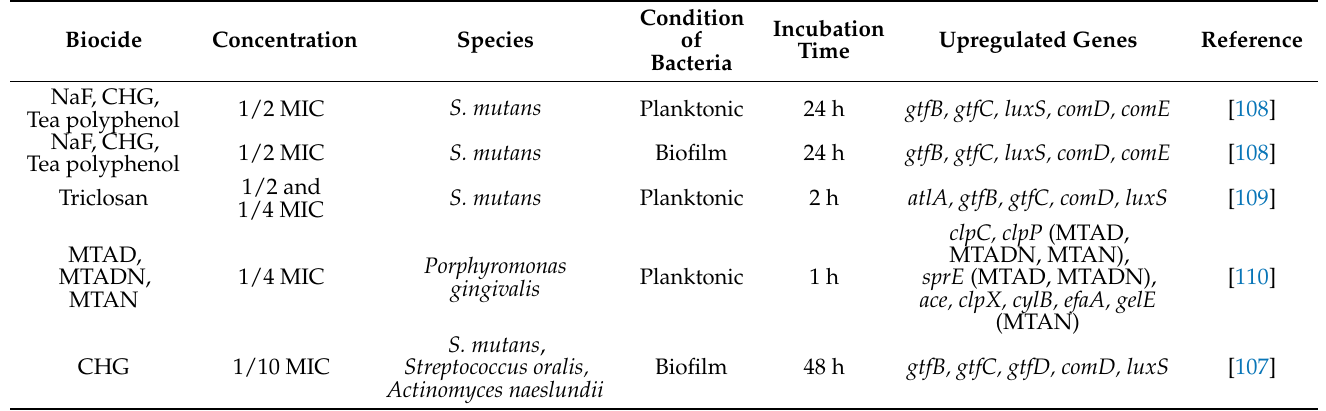
Table 4. A summary of representative experiments demonstrating that sub-minimum inhibitory concentration of antimicrobial agents upregulated pathogenic